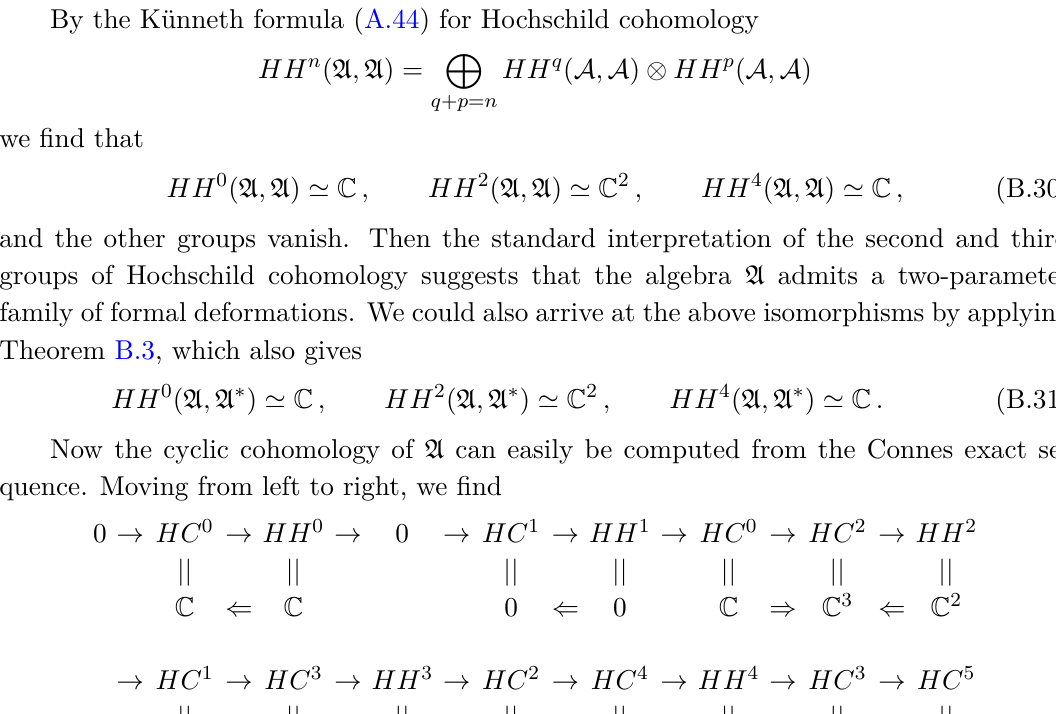
· · · · · · Table 4 . The basis cohomology classes of HC • ( A ⊗ Λ) . There are only two primary classes φ 0 ∈ HC 0 ( A ) and φ 2 ∈ HC 2 ( A ) ; the classes λ ± ’s span HC • (Λ) . acting on A by symplectic reflections. The associated Lie algebra L ( A ) contains a finite- 2 dimensional subalgebra sp ( R ) generated by the homogeneous quadratic polynomials in q ’s 4 and p ’s over reals. The well known isomorphism sp ( R ) ’ so (3 , 2) relates this algebra with 4 the group of isometries of 4 d anti-de Sitter space, thereby explaining the relevance of the algebra (B.29) to 4 d